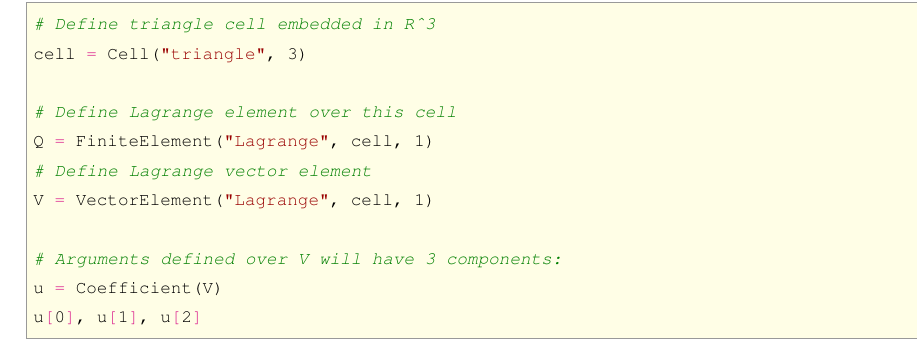
Fig. 3. UFL code defining scalar and vector finite elements on a triangle embedded in R 3 . This code is included in the Supplement as snippets/finiteelement.ufl.